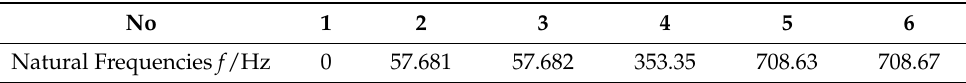
Table 2. The first six natural frequencies of the micro-manipulator. No Natural Frequencies f /Hz